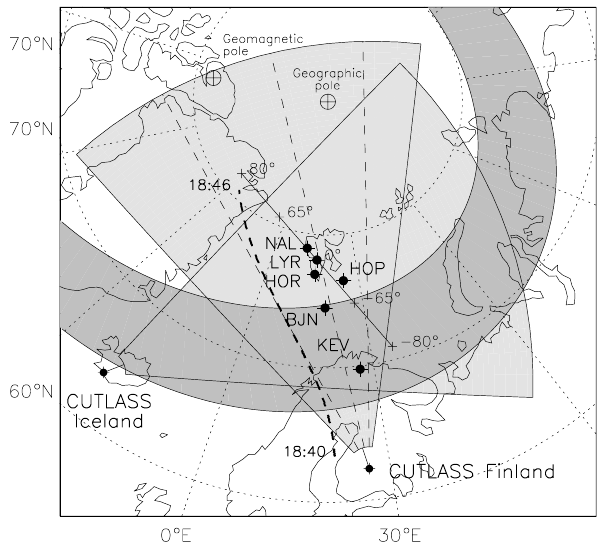
Fig. 1. Map showing the fields of view of the CUTLASS radars at Hankasalmi, Finland and Pykkvibaer, Iceland. The directions of three of the 16 beams, 4 (eastern), 9 (central) and 13 (western), of the Finland radar are marked by dashed lines. The direction of the scan of the meridian scanning photometers at Longyearbyen (full line), the locations of five IMAGE magnetometer stations (crosses), and the trajectory of the DMSP spacecraft, F12, (thick dashed line) are also